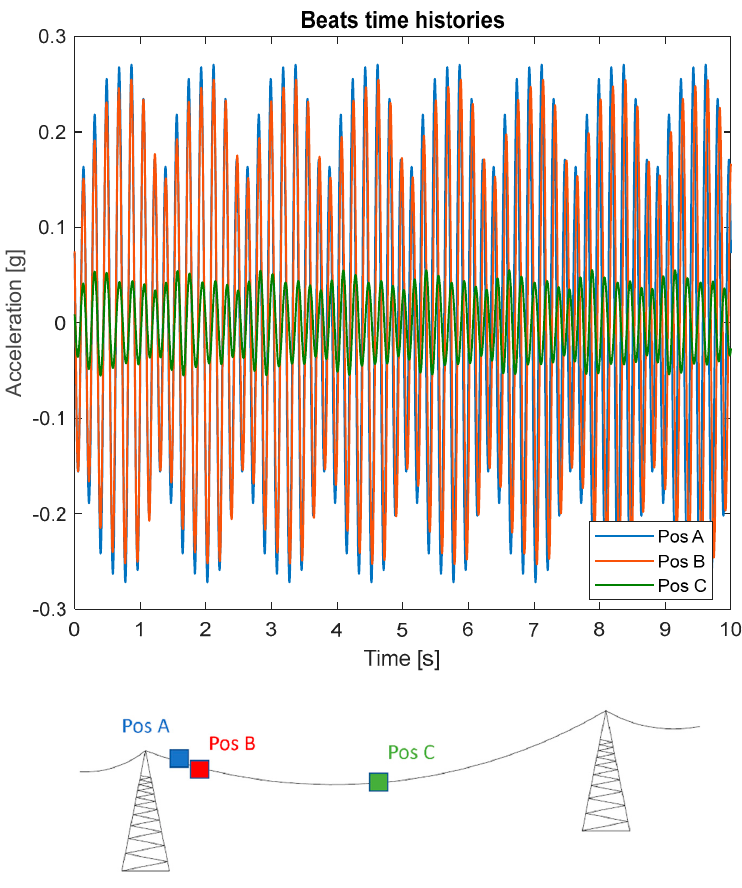
Figure 5. Experimental measurements of beats characterizing the aeolian vibrations phenomenon.